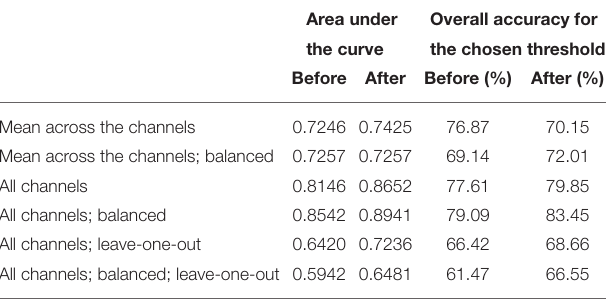
TABLE 1 | Main results of the fitted models: In non-balanced models, the overall accuracy is reported as the highest accuracy reached (assessed across all thresholds providing true positive rate above 50% and false positive rate below 50%); for the position of the points on the ROC curves see Figures 2 , 3